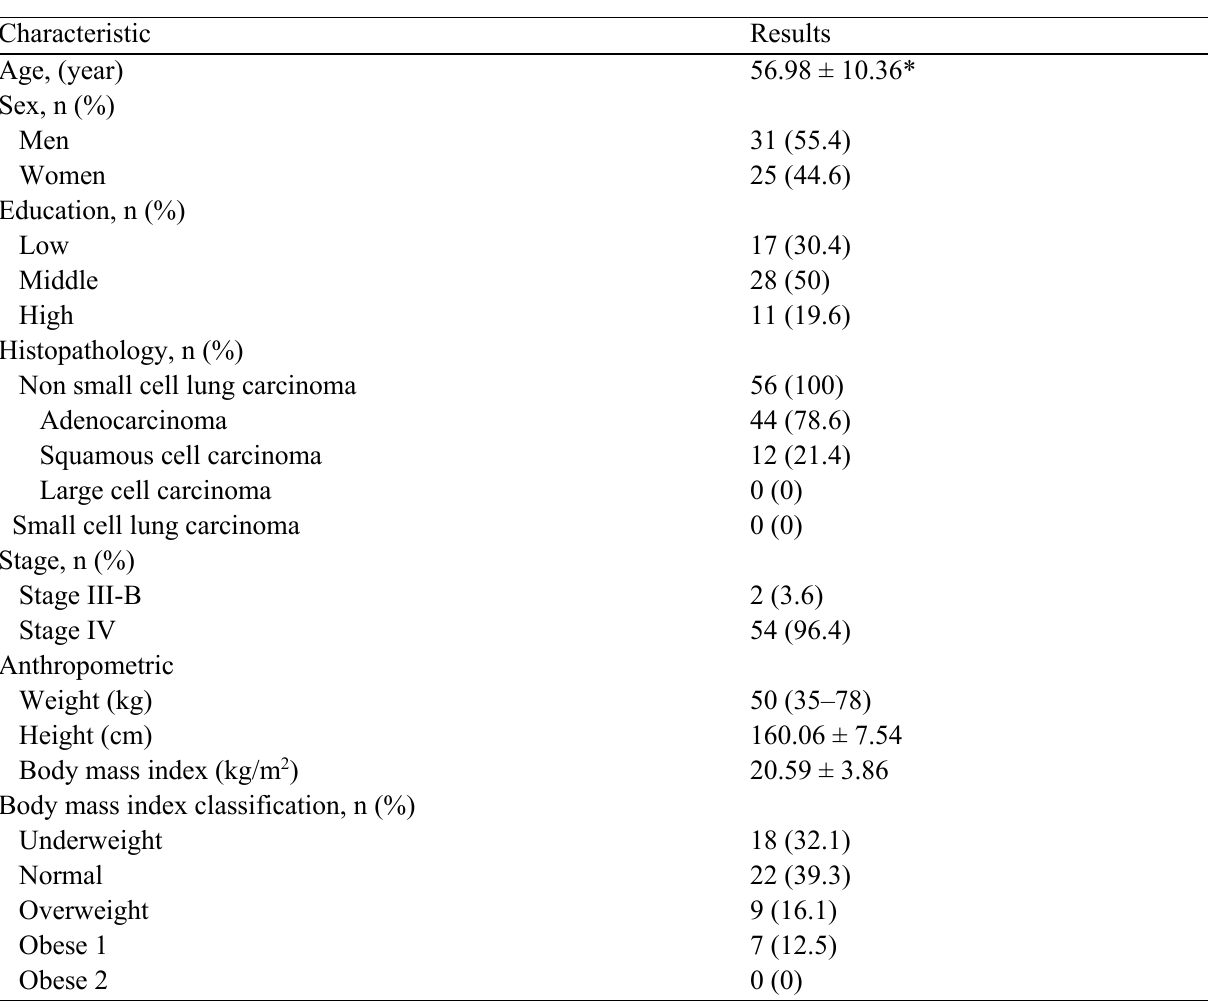
Table 1. Characteristic of subjects (n=56)